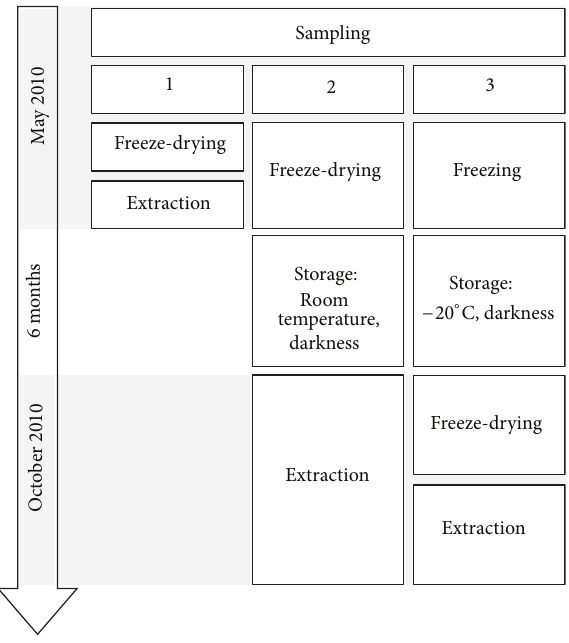
Figure 2: Grateloupia turuturu : protocol for the sampling strategy and storage